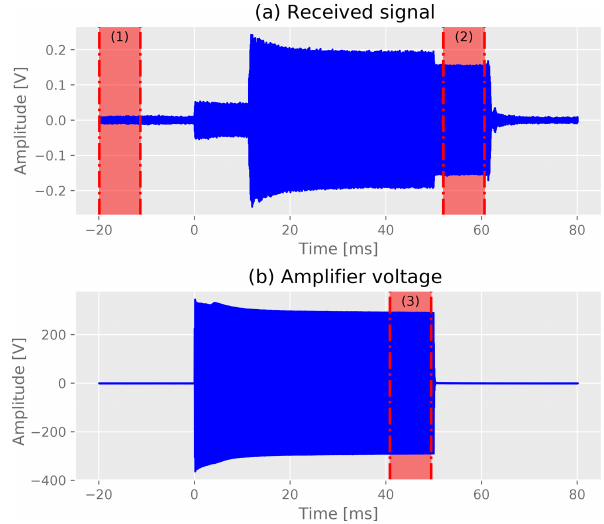
Figure 4. Waveform from measurement series 12 at 12kHz (a) and the synchronously measured sending amplitude (b) . The indicated windows 1 to 3 are relevant for the data analysis and are discussed in the